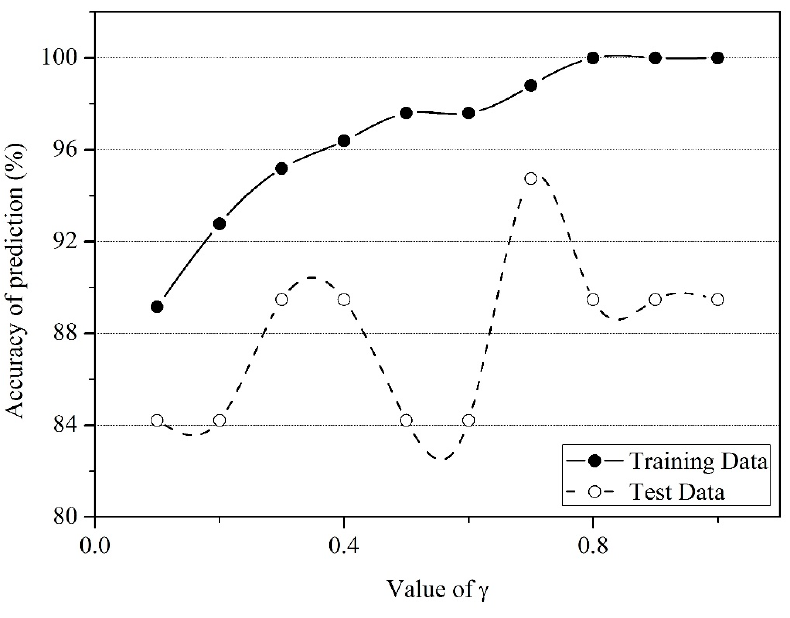
Figure 8. Optimisation of the parameter 𝜸 at C = 500